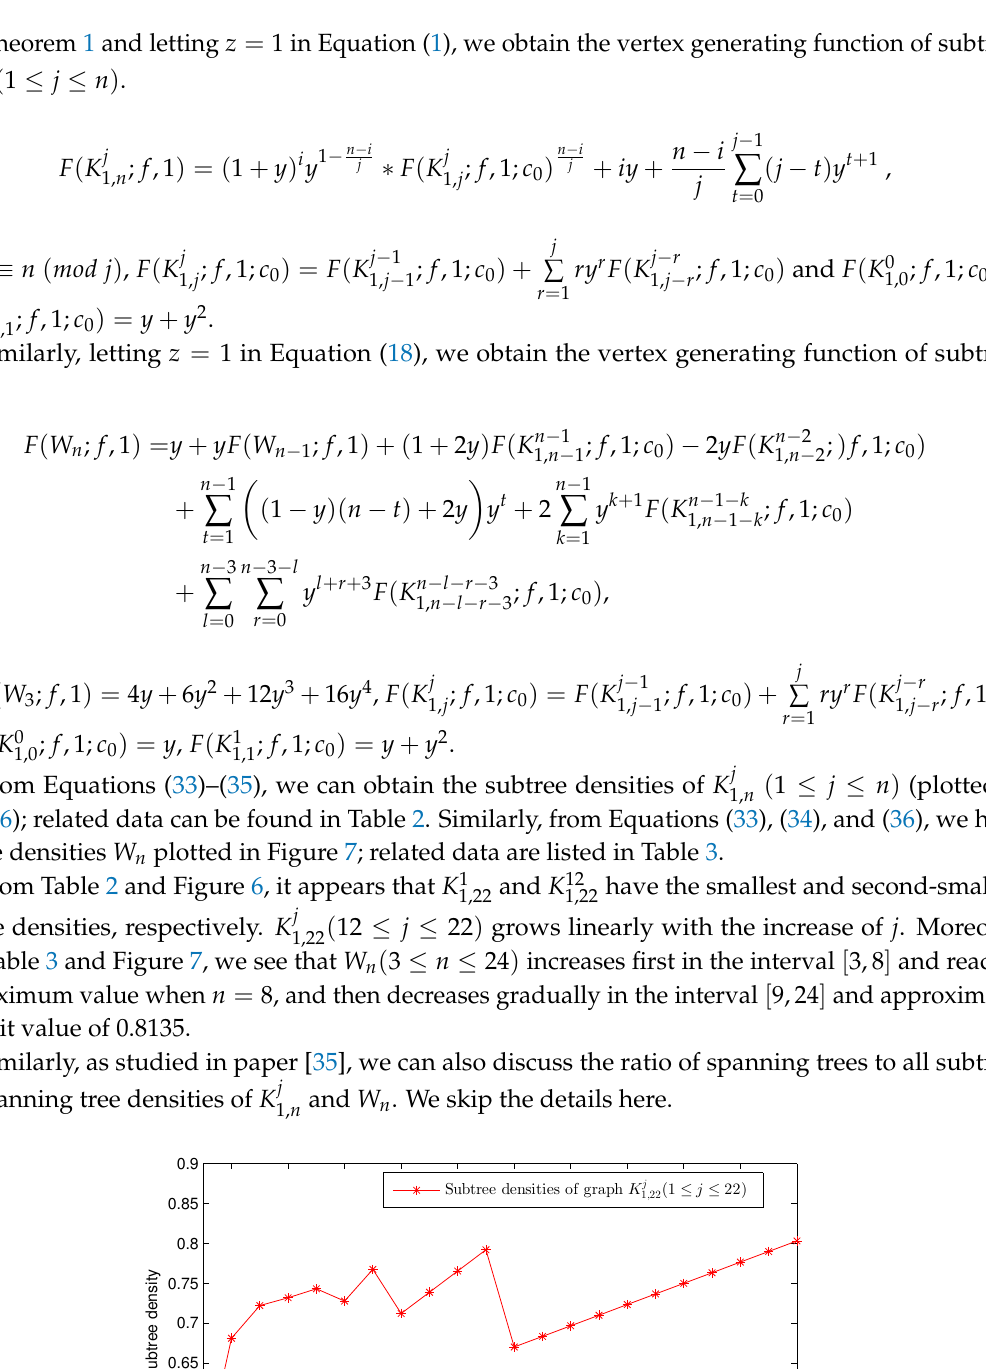
Figure 6. Subtree densities of the graphs K j